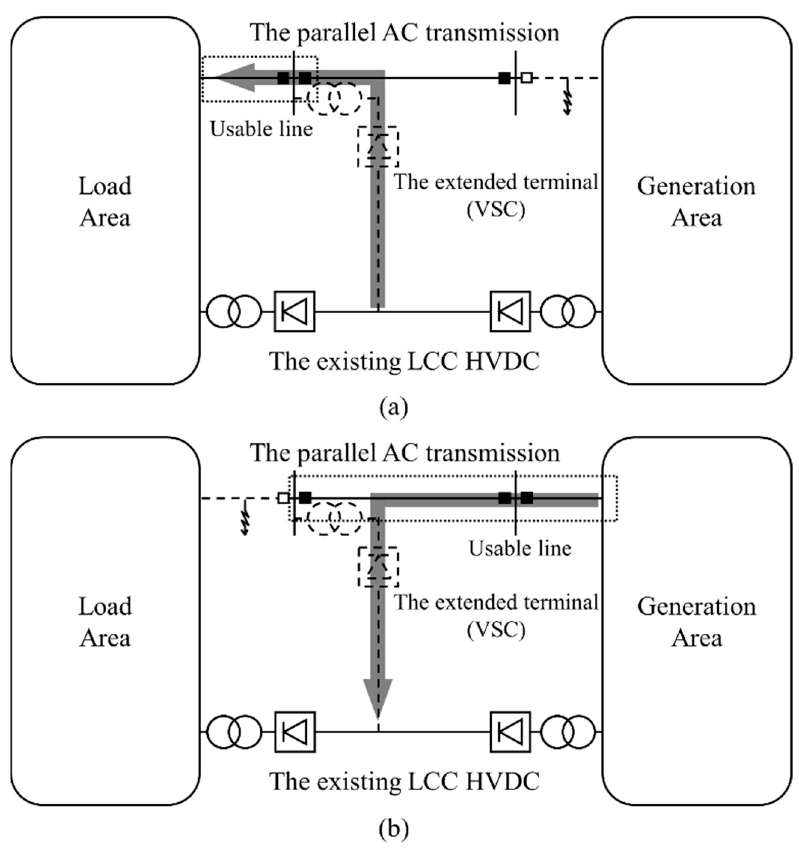
Figure 2. Brief operation strategy for the extended MTDC: ( a ) Power flow direction of the Voltage Source Converter (VSC) with the event at the generation side. ( b ) Power flow direction of the VSC with the event at the load side.